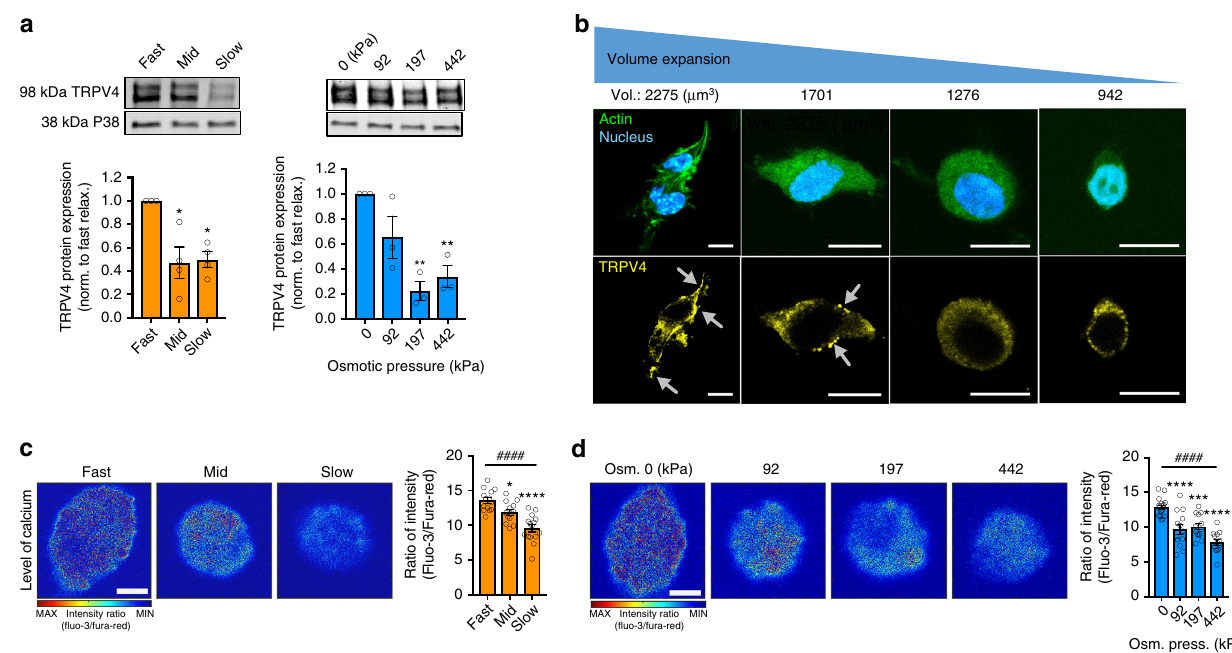
Fig. 3 TRPV4 expression and activation is strongly correlated with volume expansion. a Western blot analysis and quanti fi cation of TRPV4 ion-channel protein expression (TRPV4) in MSCs cultured in hydrogel with varying stress relaxation and in fast-relaxing hydrogel with altered osmotic pressure for 7 days (** p <0.01 and * p <0.05, respectively, compared with fast stress relaxation and 0 kPa osmotic pressure case by one-way ANOVA test). b Representative images of immunohistochemical stainings of TRPV4 (yellow), actin (green), and nucleus (blue) of MSCs with different average volume of single cells. Arrows indicate a region of dense TRPV4 staining at cell periphery. Scale bar, 10 µ m. c , d Representative images and quanti fi cation of intracellular calcium in MSCs cultured in hydrogel with varying stress relaxation ( c ) and in fast-relaxing hydrogel with altered osmotic pressure ( d ) for 7 days (**** p <0.0001, *** p <0.001, and * p <0.05, respectively, compared with fast stress relaxation and 0 kPa osmotic pressure case by one-way ANOVA test, #### p <0.0001 by Spearman ’ s rank correlation). Scale bar, 5 µ m. All data are shown as mean ±